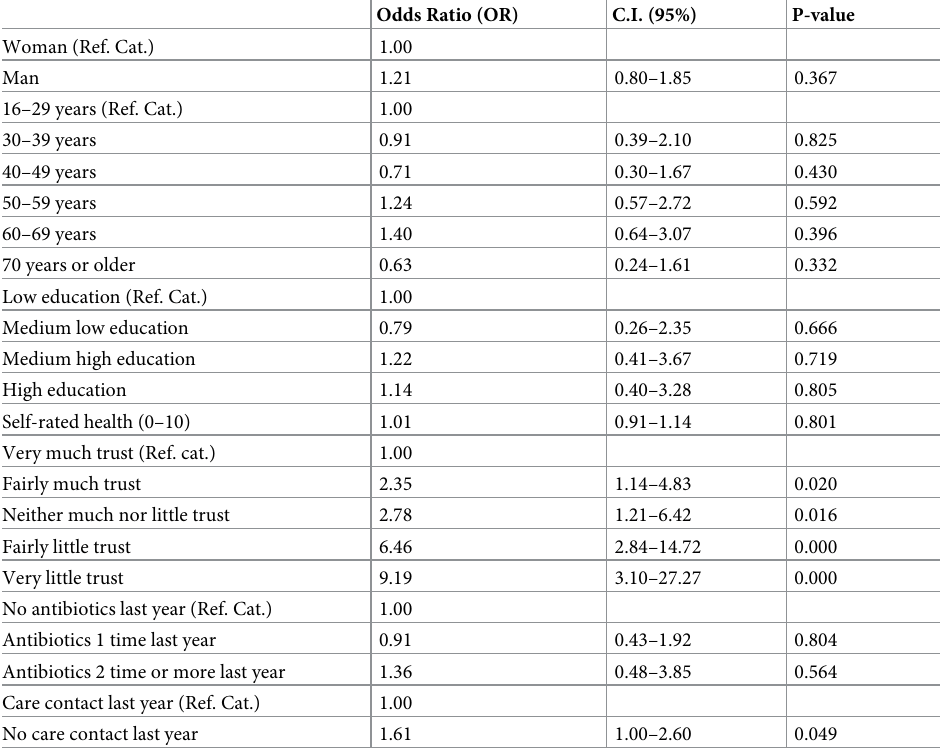
Table 3. Previous non-prescription acquisition of antibiotics, according to demographic variables, self-rated health, trust in health care, antibiotic use and health care contacts. Odds ratios (OR), 95 confidence intervals (95% CI) and p-values (n = 4 169). Odds Ratio (OR) C.I. (95%)